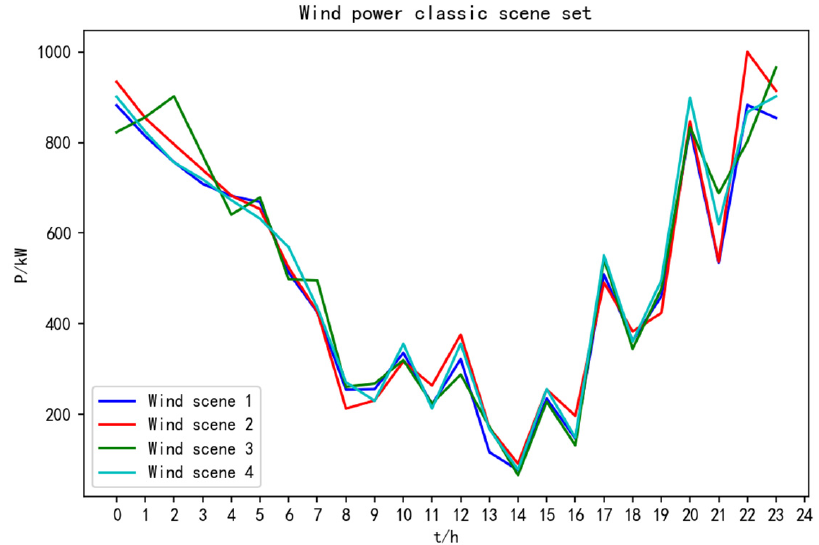
Figure 7. Wind power output scenario generated by fuzzy clustering algorithm.